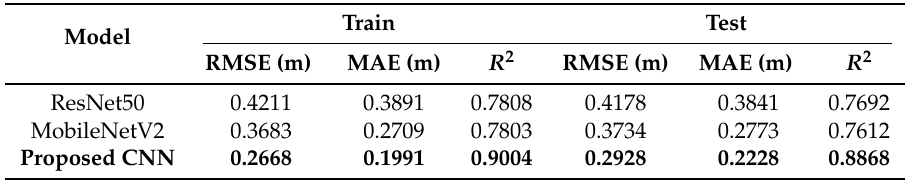
Table 1. Estimations results of root mean square error (RMSE), mean absolute error (MAE) and R 2 for train and test datasets using all three deep neural